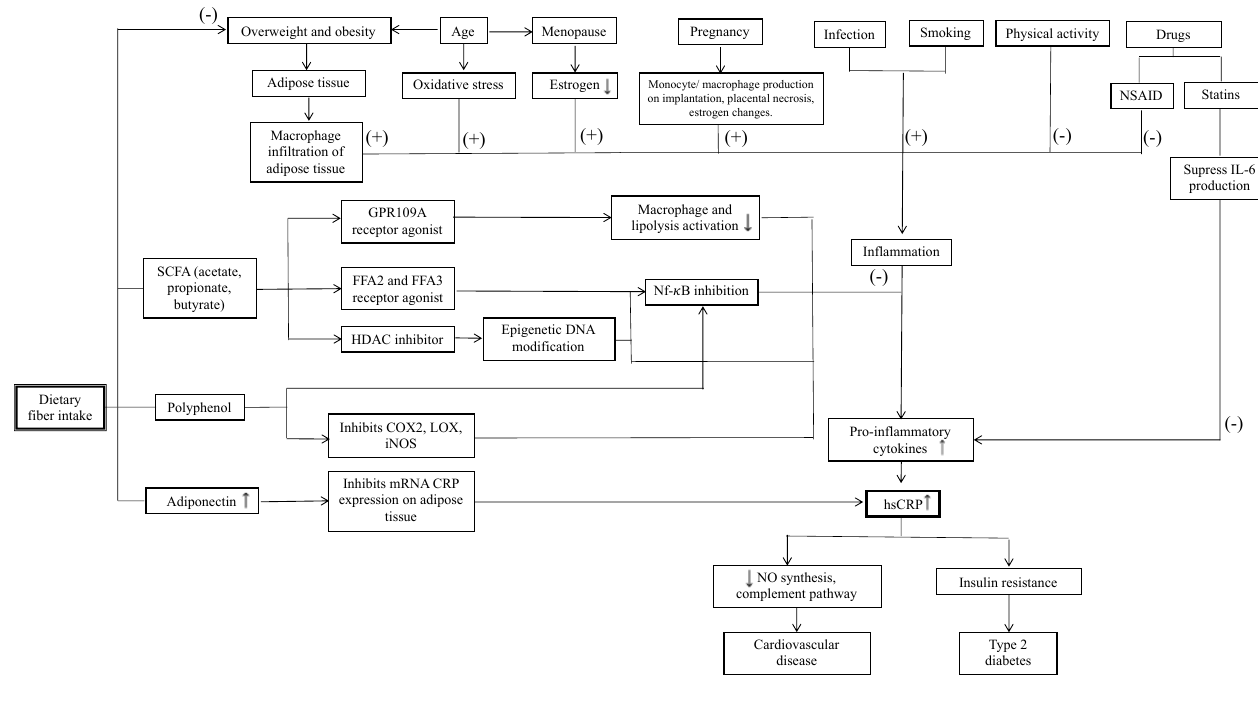
Figure 1 . Effect of Dietary Fiber Intake on Serum